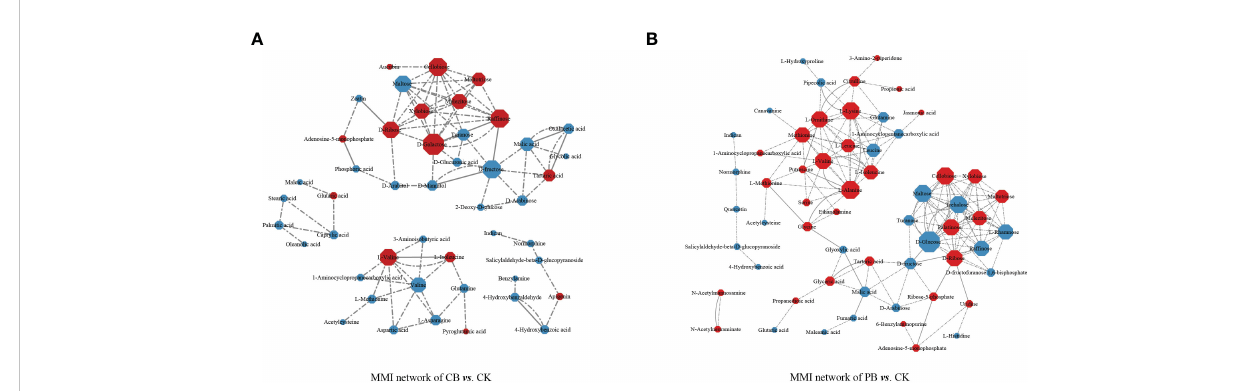
FIGURE 5 The metabolite-metabolite interaction network (MMI) of signi fi cantly different metabolites that participated in KEGG pathways. (A) indicates the C. paliurus intercropping with B. striata (CB) vs. Control and (B) indicates the Moso bamboo intercropping with B. striata (PB) vs. Control. The node indicates the correlated metabolisms in these networks, and the lines between the two nodes represent the biological relationships between two metabolites. The size of the node indicates the degree value, and the color indicates the log 2 FC (red indicates up-regulated and blue indicates